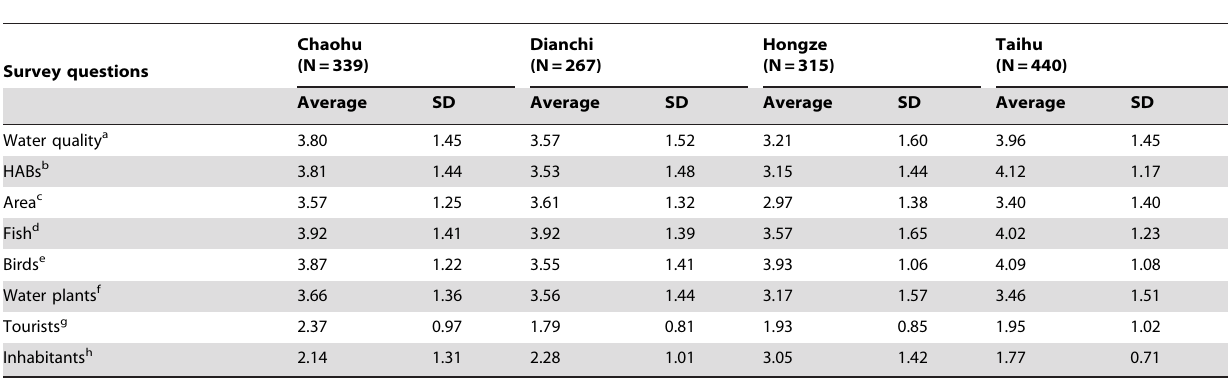
Table 2. Public Perception of Ecological Change of Four